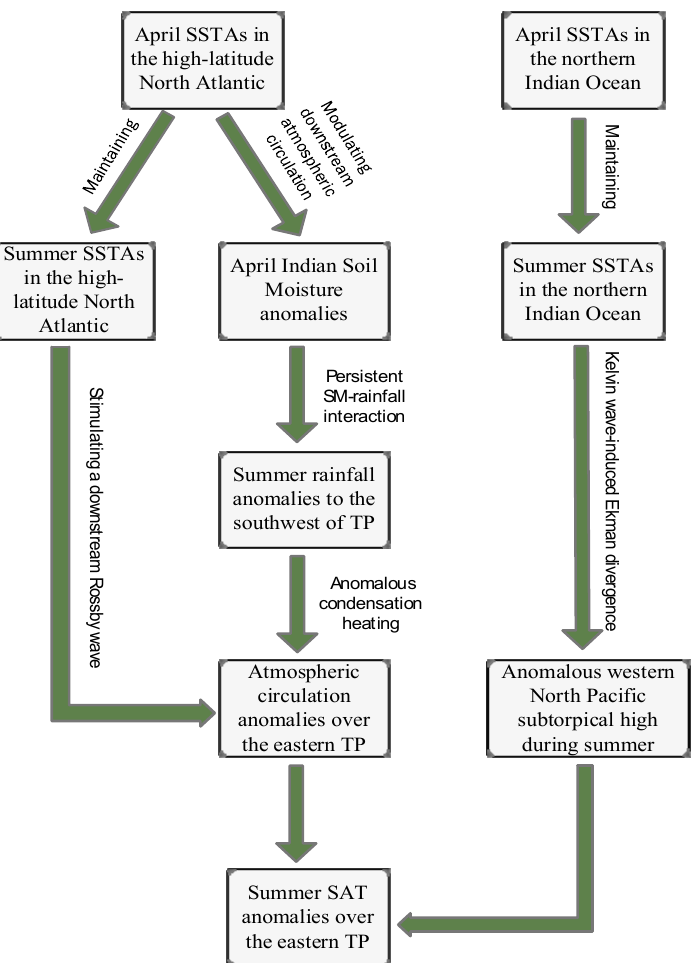
Figure 12. Schematic diagram summarizing the processes linking the summer eastern TP SAT and the precursory sea–land signals. the precursory sea–land